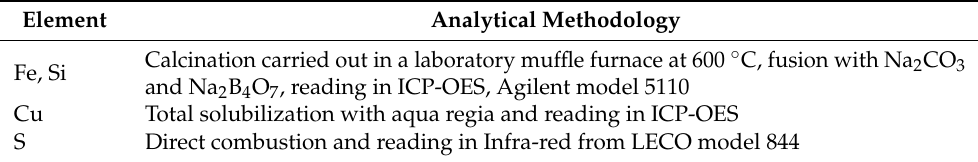
Table 2. Analytical methods used in the chemical analysis of the samples. Element Analytical